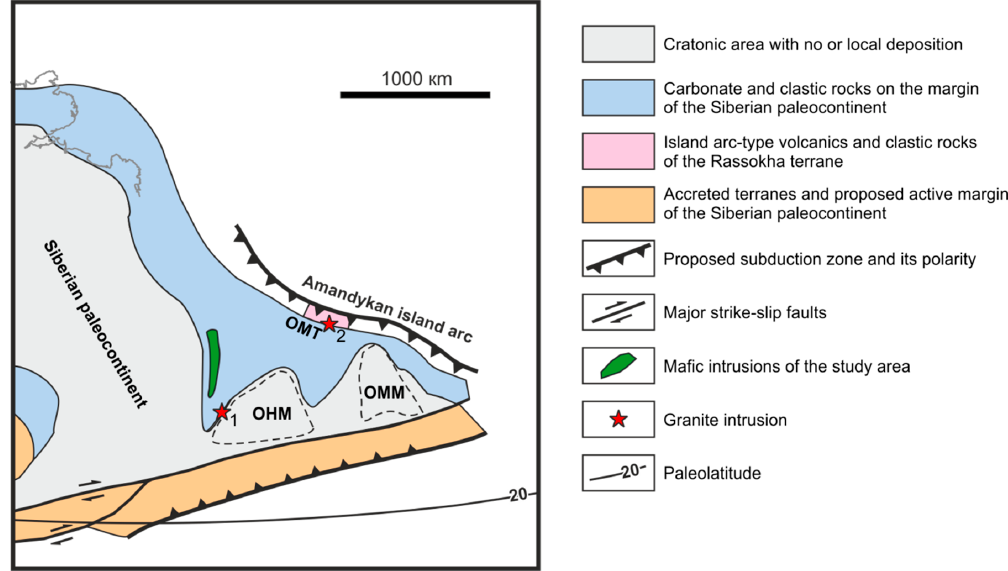
Figure 14. Paleotectonic reconstruction of the eastern part of the Siberian craton. Modified from [11]. Granite intrusions: 1—440 ± 2 Ma [70], 2—445.7 ± 1.5 Ma [71]. OHM—Okhotsk massif, OMM—Omolon massif, and OMT—Omulevka terrane.